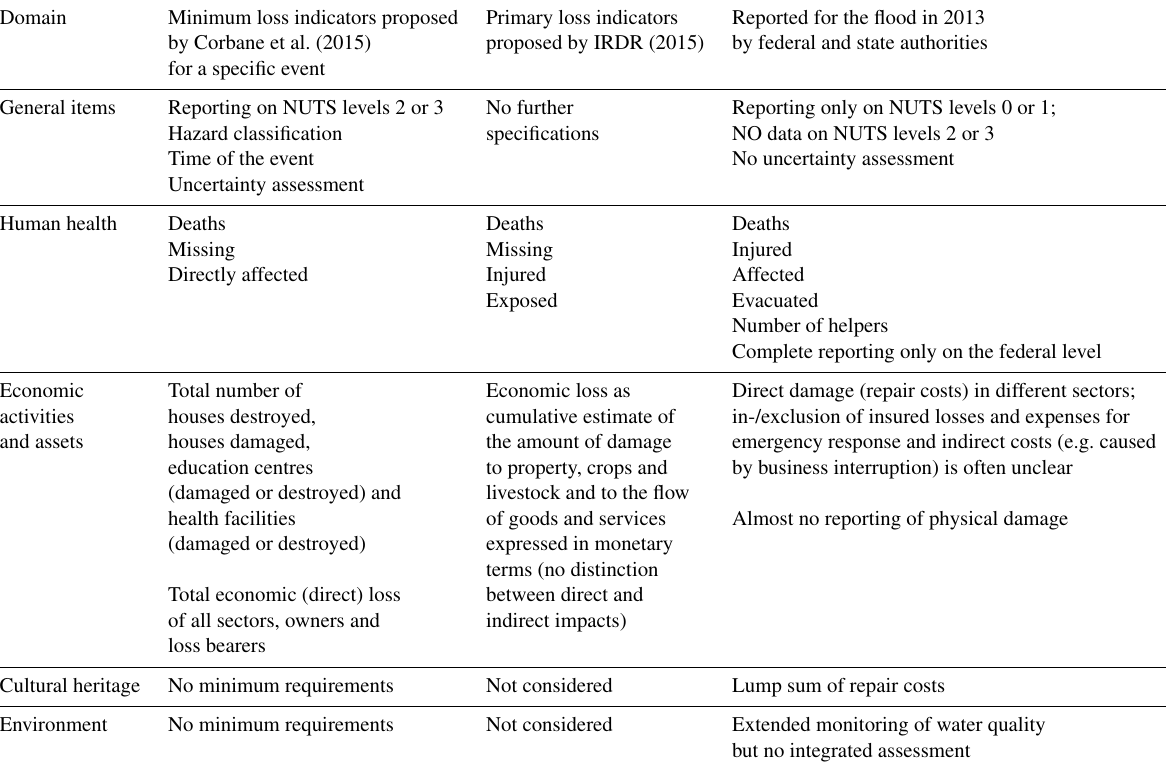
Table 4. Financial losses of companies affected by the flood in June